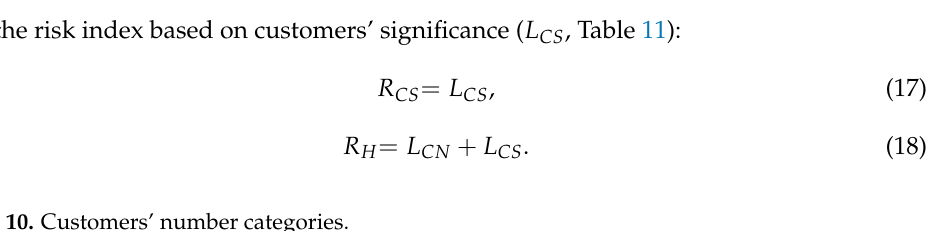
Table 10. Customers’ number categories.